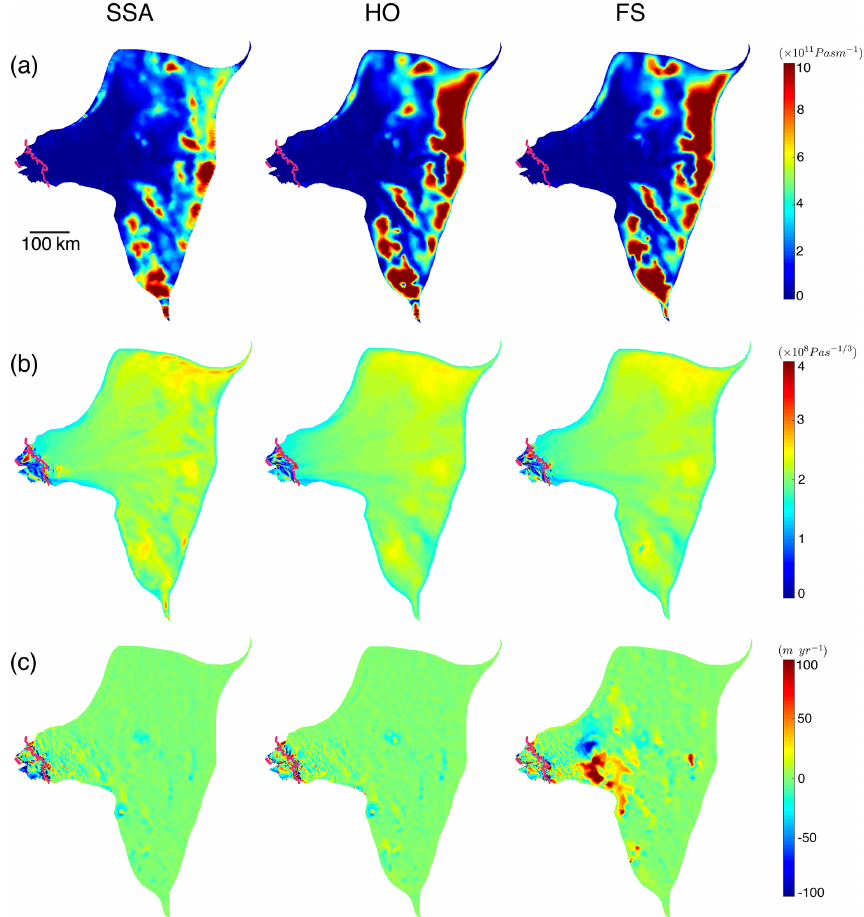
Figure 3. Inversion results. (a) Basal friction coefficient inferred for SSA (left column), HO (middle column) and FS (right column) models. (b) Depth-average ice viscosity parameter for the three models, combined with thermal model output over grounded ice and inversion results over floating ice. (c) Difference between modeled and observed surface velocity for the three models. The pink lines in each panel are grounding line